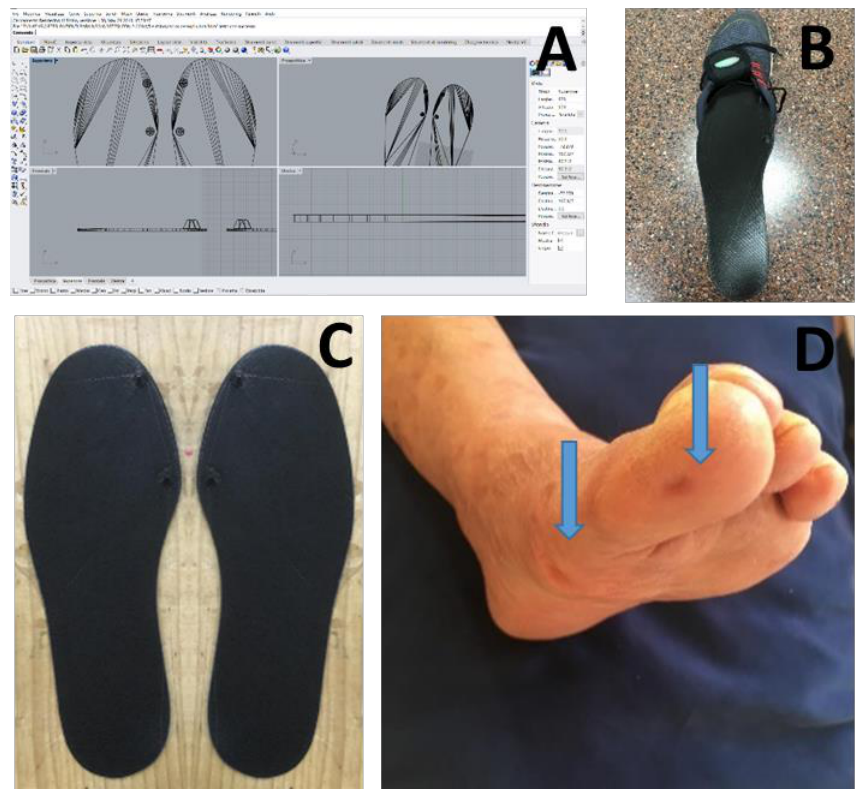
Figure 1. Details of the realization process of the customized 3D printed insoles design used in this study, ( A ) and the insoles ( C ) inside the shoe with the inertial measurement unit attached to shoelaces with a Velcro strap ( B ). Blue arrows indicate the effect of blunted cones on the foot after mechanical peripheral stimulation on the plantar surface of the first metatarsal joint and distal phalanx ( D ).